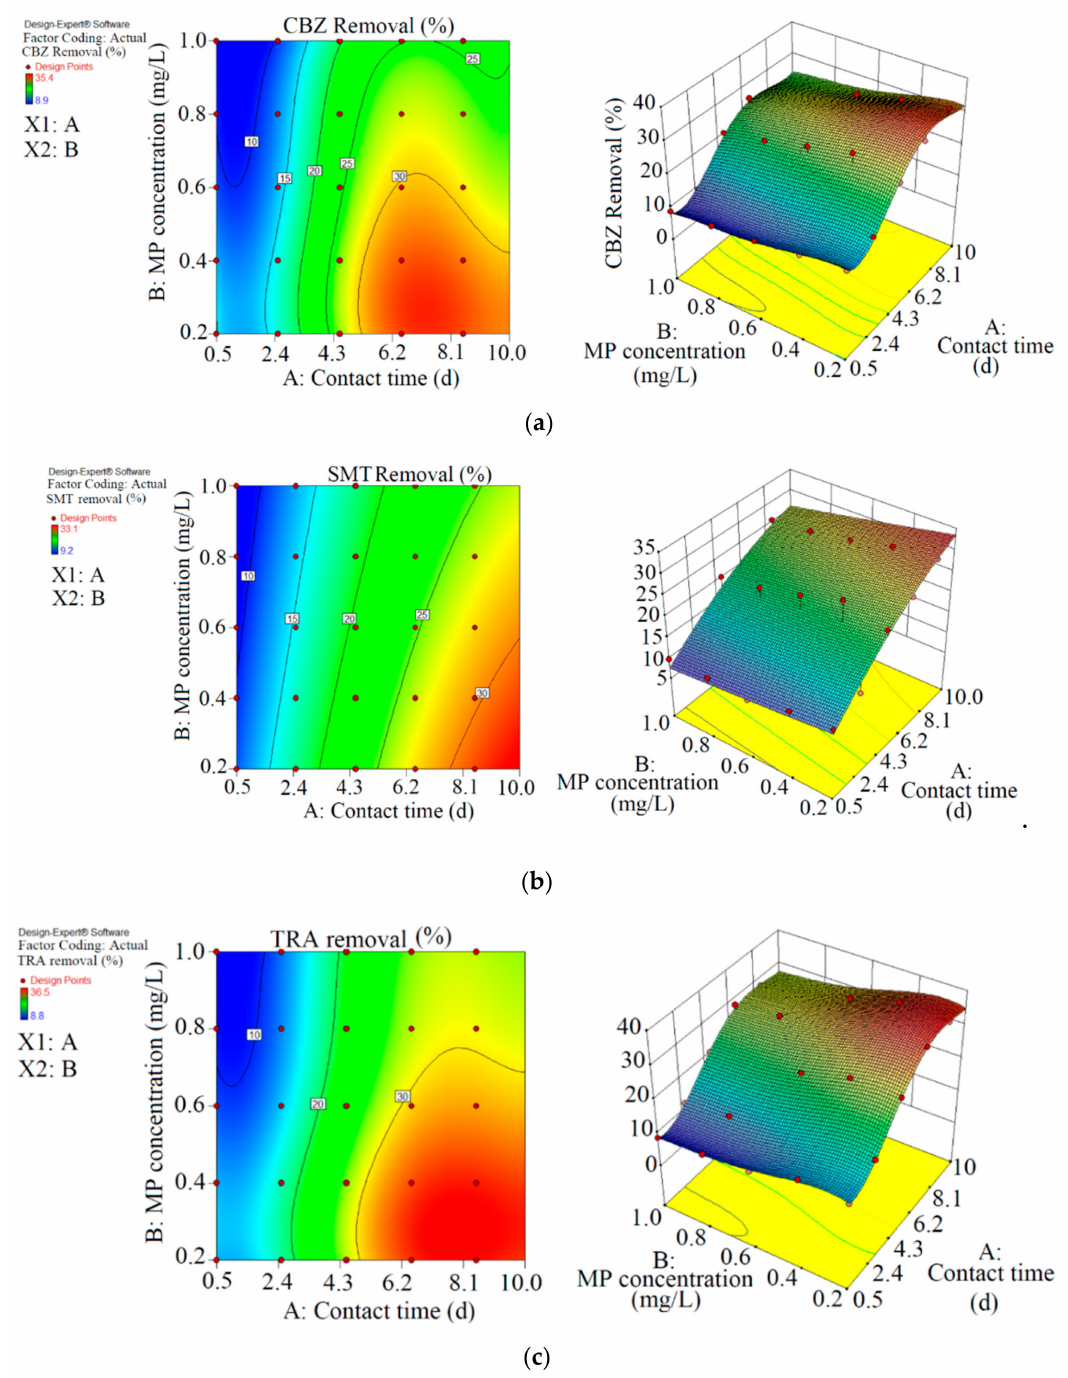
Figure 2. 3D plots for the removal of CBZ ( a ), SMT ( b ) and TRA ( c ) by the first reactor based on the